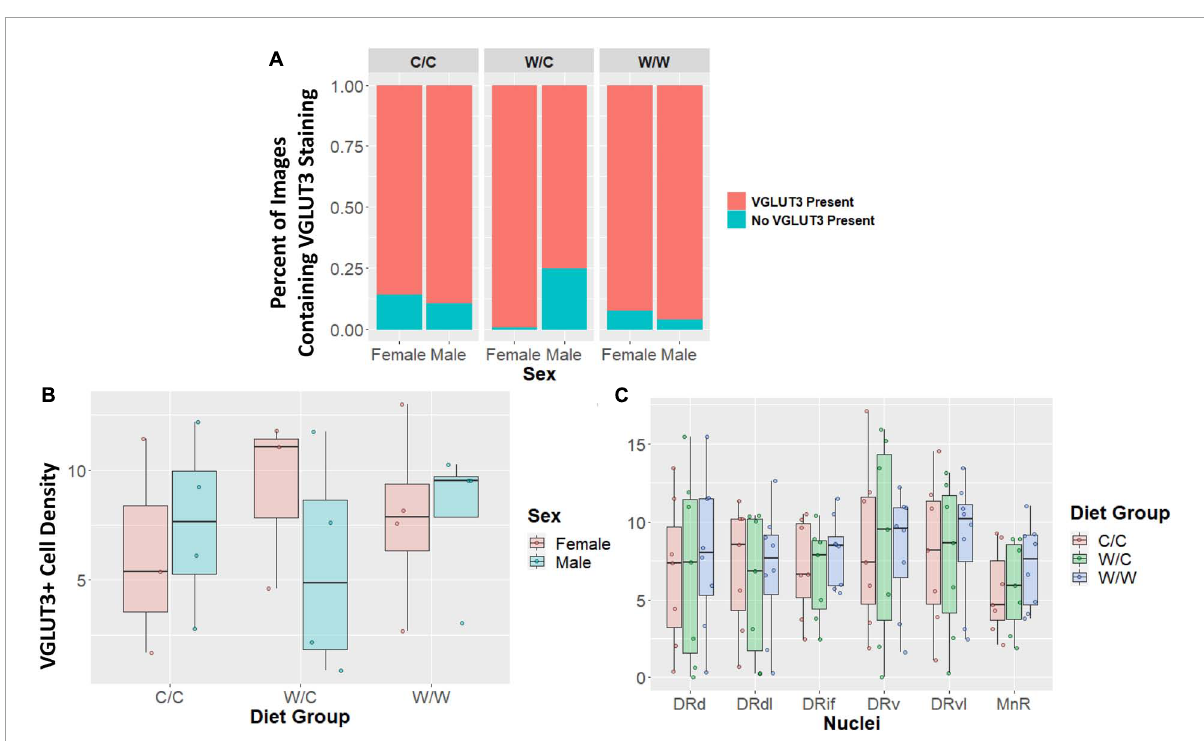
FIGURE5 Vesicular glutamate transporter 3 (VGLUT3) cell density does not appear to be impacted by maternal Western-style diet (WSD). Data in panel (A) is expressed as percentages of images containing either some or no VGLUT3 staining. Data in panels (B/C) are expressed as box plots with boxes indicating the 1st–3rd quartile range and the median expressed as the horizontal bold line. (A) No significant diet or sex main effects were found when comparing the percentage of images that either contained some VGLUT3 staining or no staining at all. (B) VGLUT3 cell density was not significantly impacted by perinatal diet. (C) VGLUT3 cell density in specific subregions were not uniquely impacted by perinatal diet. DRd, dorsal nucleus of the dorsal raphe; DRdl, dorsolateral nucleus of the dorsal raphe; DRv, ventral nucleus of the dorsal raphe; DRvl, ventrolateral nucleus of the dorsal raphe; MnR, median raphe